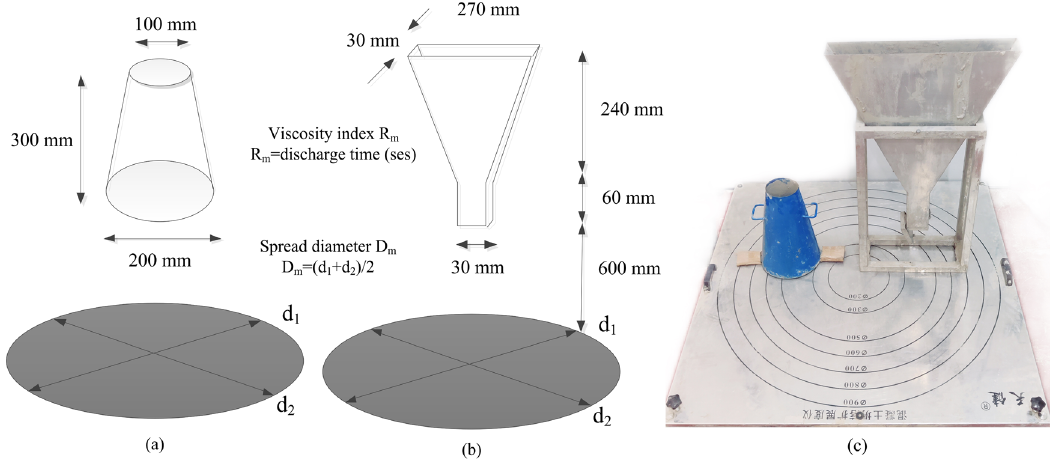
Figure 5: Schematic diagram of slump and v - funnel test ( a – b ) , experimental instrument diagram ( c ) .